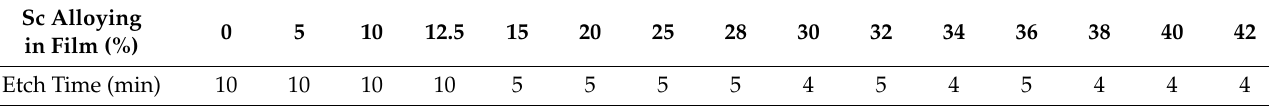
Table 5. Scandium concentration vs. etch time (long etch in 30% KOH at 45 °C). Sc Alloying Sc